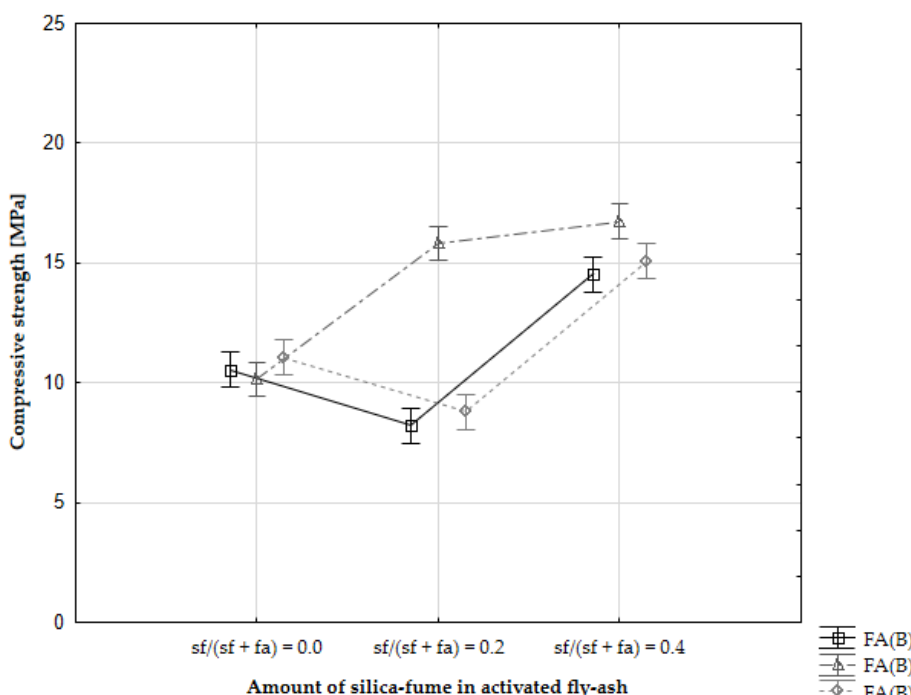
Figure 7. Two-day compressive strength results of cement mortars with activated biomass fly ash (ANOVA certainty in whiskers).